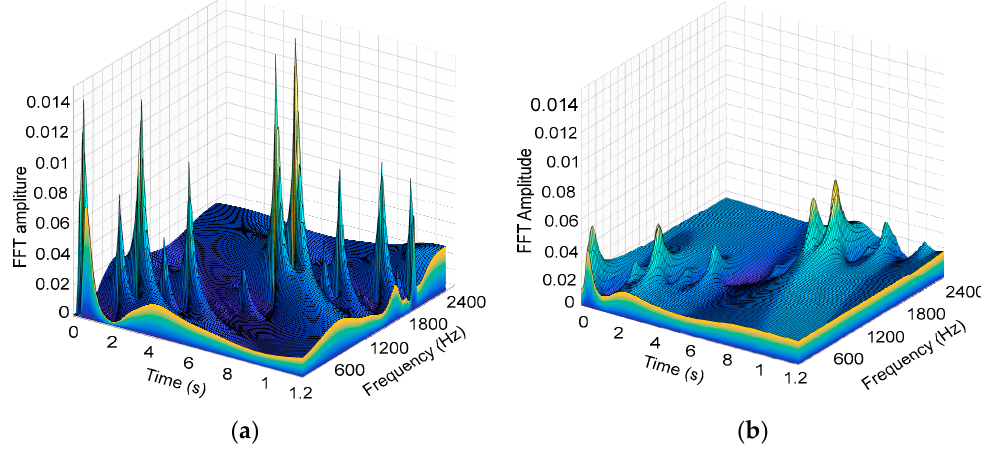
Figure 12. Waterfall spectrum of rotor-to-stator contact: ( a ) without fl uid; ( b ) with fl uid.